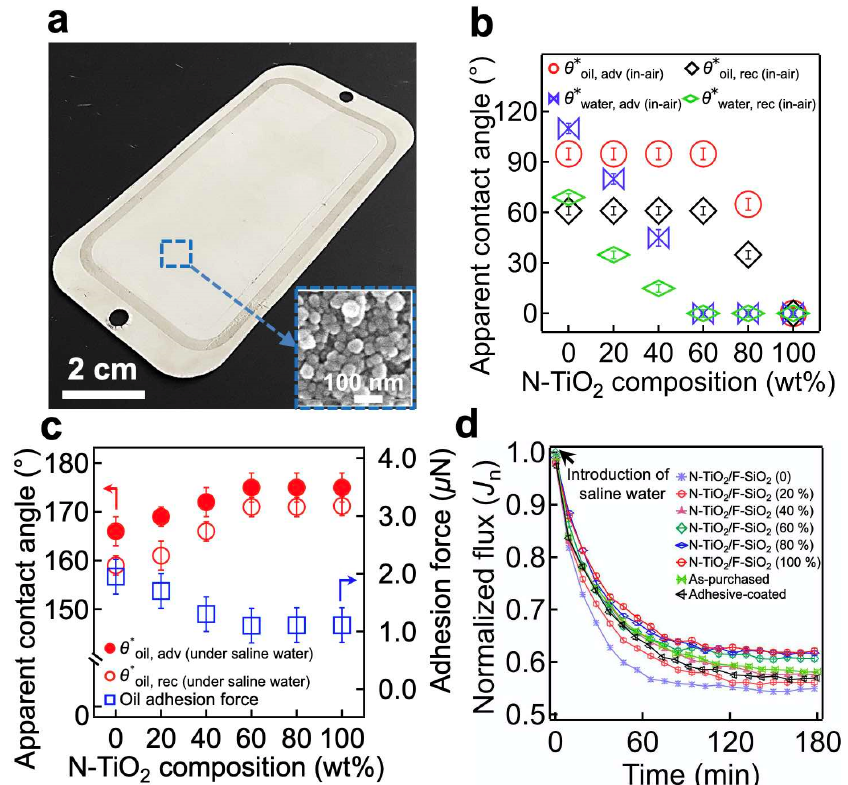
Figure 3. ( a ) A photograph showing a commercial filter coated with N-TiO 2 /F-SiO 2 (60 wt%). The inset displays a scanning electron microscopy (SEM) image of the membrane surface, showing a hierarchical roughness with a re-entrant texture. ( b ) The measured in-air advancing and receding apparent contact angles for saline water (1.0 wt% NaCl in DI water) and oil (n-hexadecane) on the membrane surface, coated with N-TiO 2 /F-SiO 2 with varied compositions. ( c ) The measured advancing and receding apparent contact angles, as well as the adhesion force for an oil droplet (n-hexadecane) on the membrane surface, coated with N-TiO 2 /F-SiO 2 with various compositions submerged in saline water. ( d ) The normalized flux ( J n ) of the permeate through the membranes coated with N-TiO 2 /F-SiO 2 with varied compositions. The data for the as-purchased commercial filter and for the one coated only with cured adhesive were also provided for